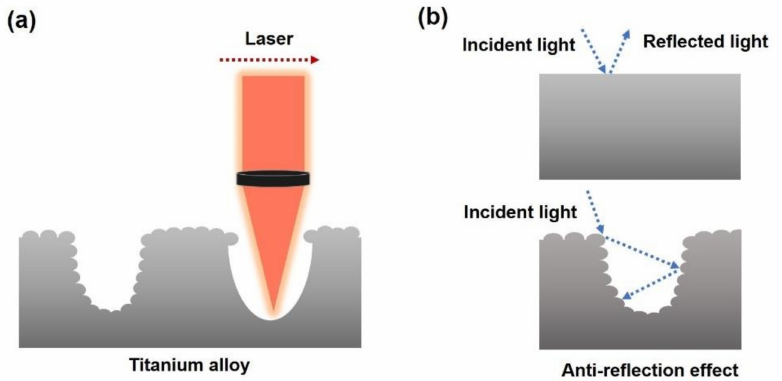
Figure 1. Schematic diagram of ( a ) laser treatment of titanium alloy surface and ( b ) surface anti- reflection